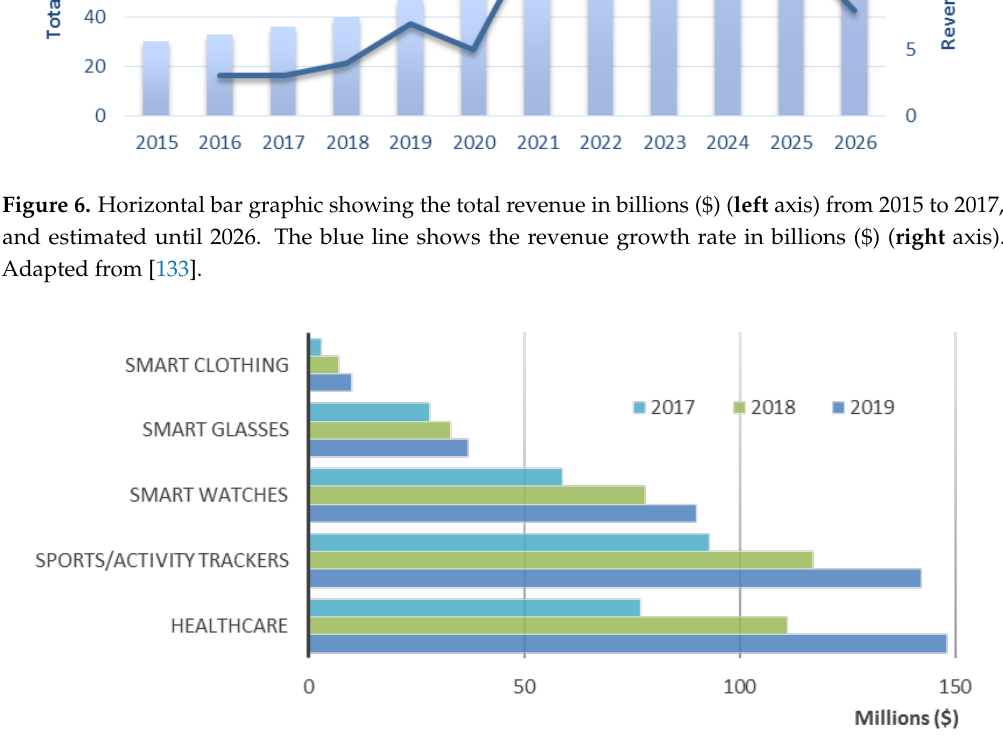
Figure 7. Horizontal bar graphic showing the trend of global market value of wearable computing devices, in millions, between 2017 and 2019. Adapted from [134].